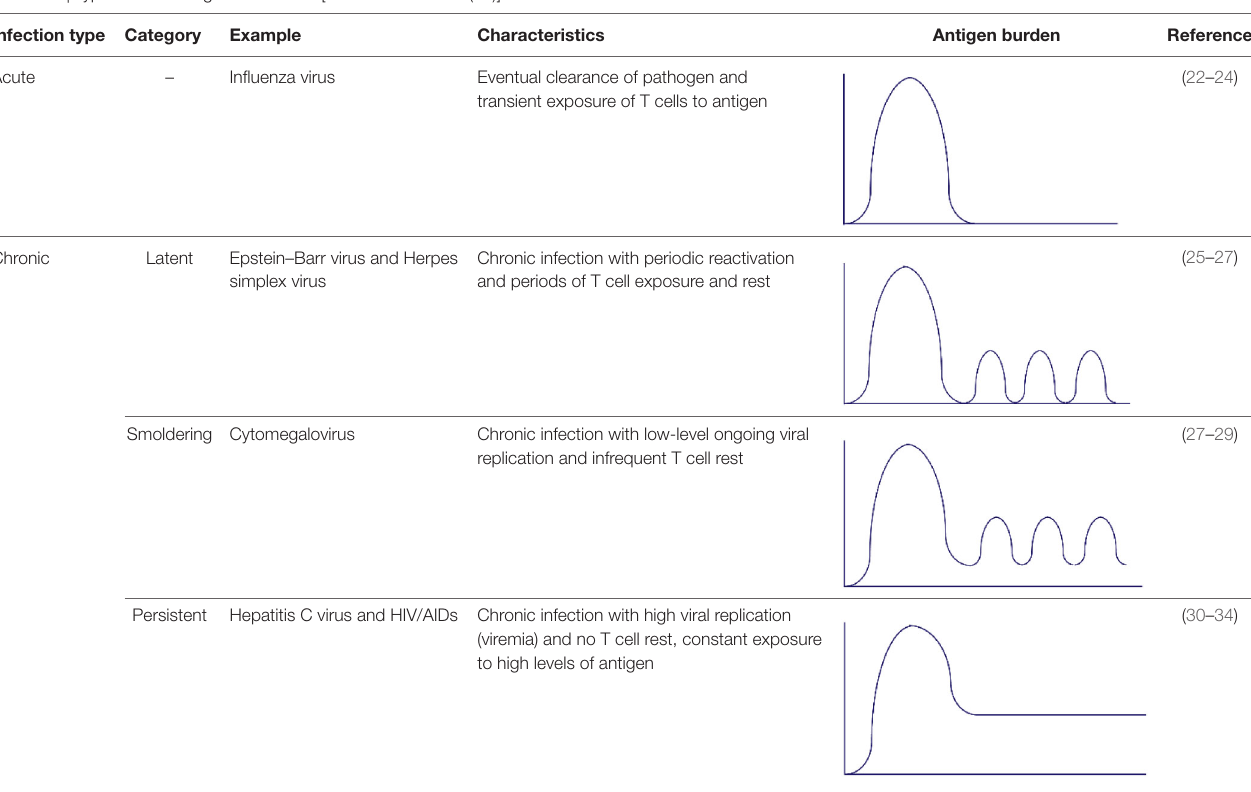
TAbLe 1 | Types of heterologous infections [modified from Ref.